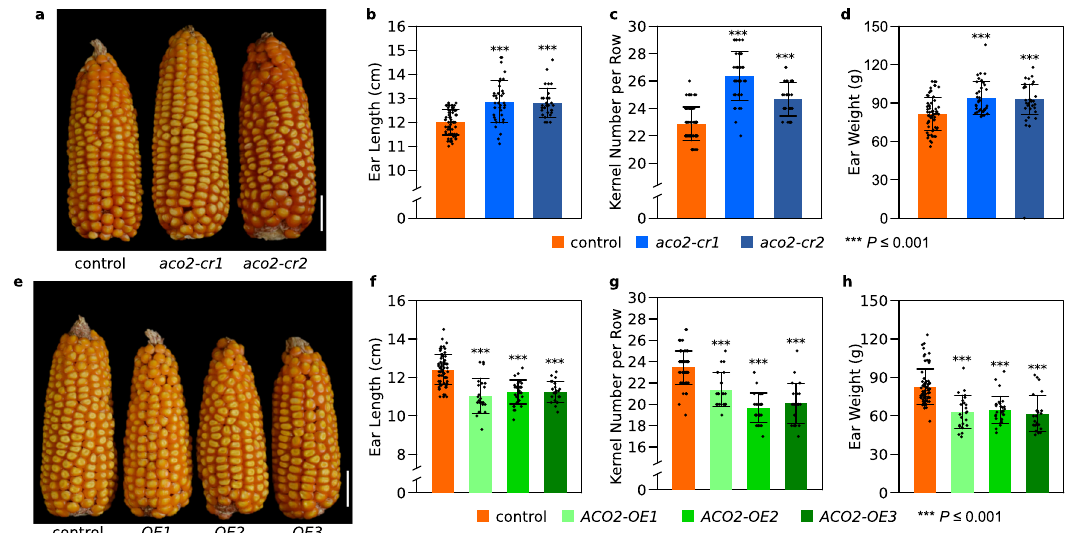
Fig. 3 Validation of ZmACO2 function by coding region knockout and overexpression. a Zmaco2 knockout alleles ( aco2-cr1 and aco2-cr2 ) made longer ears with more kernels than sibling controls; scale bar = 5 cm. Performance of control and Zmaco2 knockout alleles ( aco2-cr1 and aco2-cr2 ) on ear length ( b , p = 2.37 × 10 − 8 and 1.87 × 10 − 9 respectively), kernel number per row ( c , p = 6.82 × 10 − 20 and 1.44 × 10 − 9 respectively) and ear weight ( d , p = 1.41 × 10 − 5 and 1.15 × 10 − 4 respectively); orange bar, control, n = 64 in ( b − d ); blue bar, Zmaco2 alleles, n = 36 ( aco2-cr1 ) and 31 ( aco2-cr2 ) in ( b − d ), respectively. e ZmACO2 overexpression lines made shorter ears with less kernels than sibling non-transgenic controls; scale bar = 5 cm. f − h , Performance of ear length ( f , p = 5.79 × 10 − 10 , 1.64 × 10 − 10 and 2.32 × 10 − 9 respectively), kernel number per row ( g , p = 3.76 × 10 − 7 , 1.99 × 10 − 19 and 2.68 × 10 − 13 respectively) and ear weight ( h , p = 5.38 × 10 − 8 , 1.24 × 10 − 8 and 1.54 × 10 − 8 respectively) in controls and ZmACO2 overexpression lines; orange bar, control, n = 69 in ( f − h ); green bar, ZmACO2 overexpression line, n = 23 ( ACO2-OE1 ), 29 ( ACO2-OE2 ) and 23 ( ACO2- OE3 ) in ( f − h) , respectively. For ( b − d ) and ( f − h ), data are presented as means ± SD. *** p -value ≤ 0.001, from a two-tailed, two-sample t-test. n is the number of ears examined in ( b − d ) and ( f − h